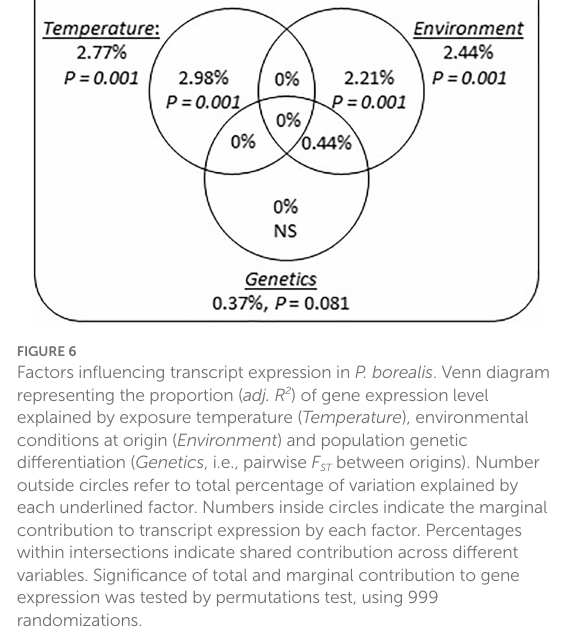
TABLE 1 ANOVA table for db-RDA models selection for factors explaining gene expression level.